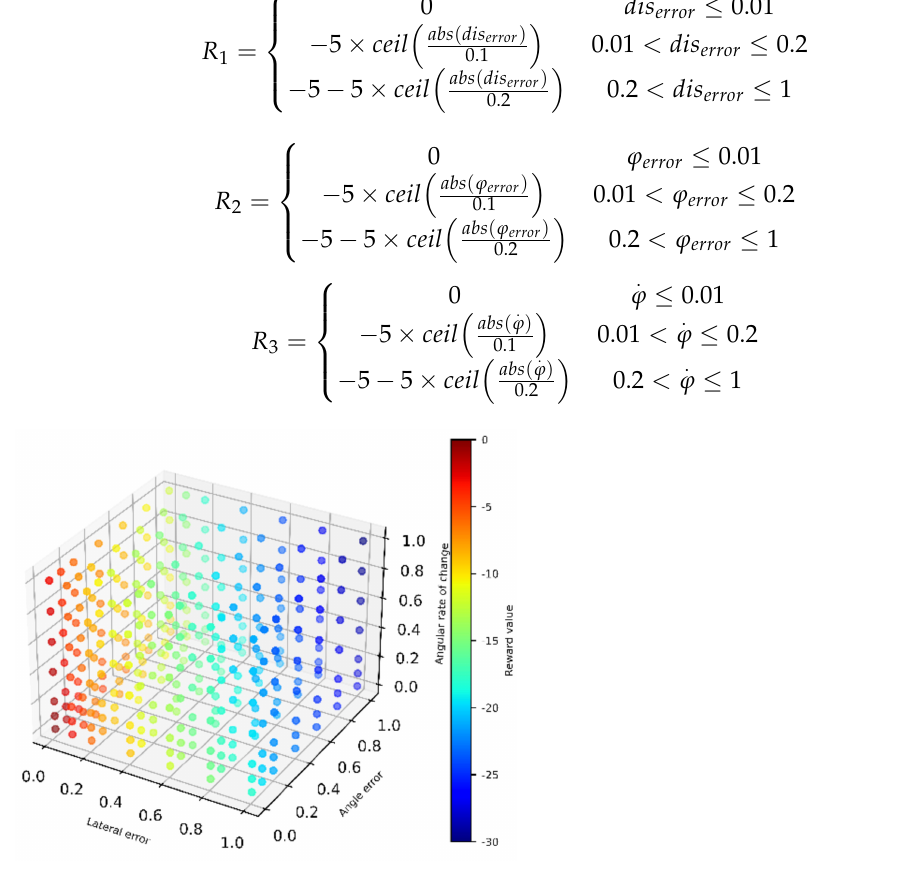
Figure 3. DDPG overall